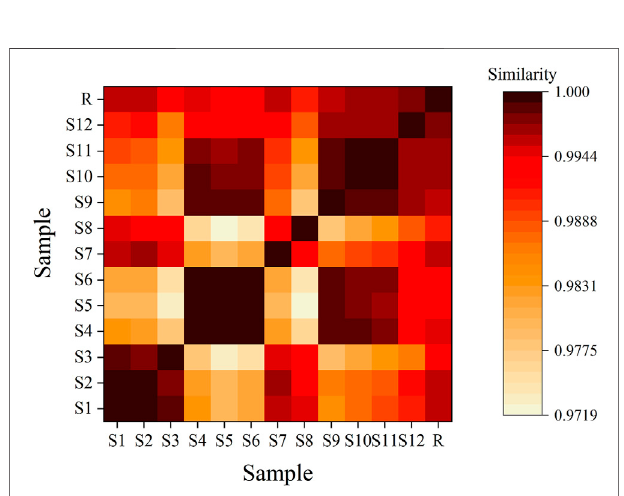
FIGURE 4 | Chromatogram similarity heatmap for standard